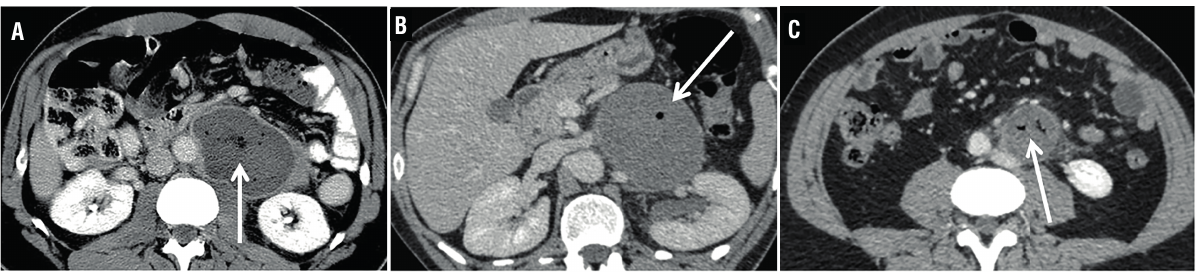
Figure 1 - Abdominal contrast-enhanced CT-scan axial cut showing gas-containing retroperitoneal mass (white arrows).